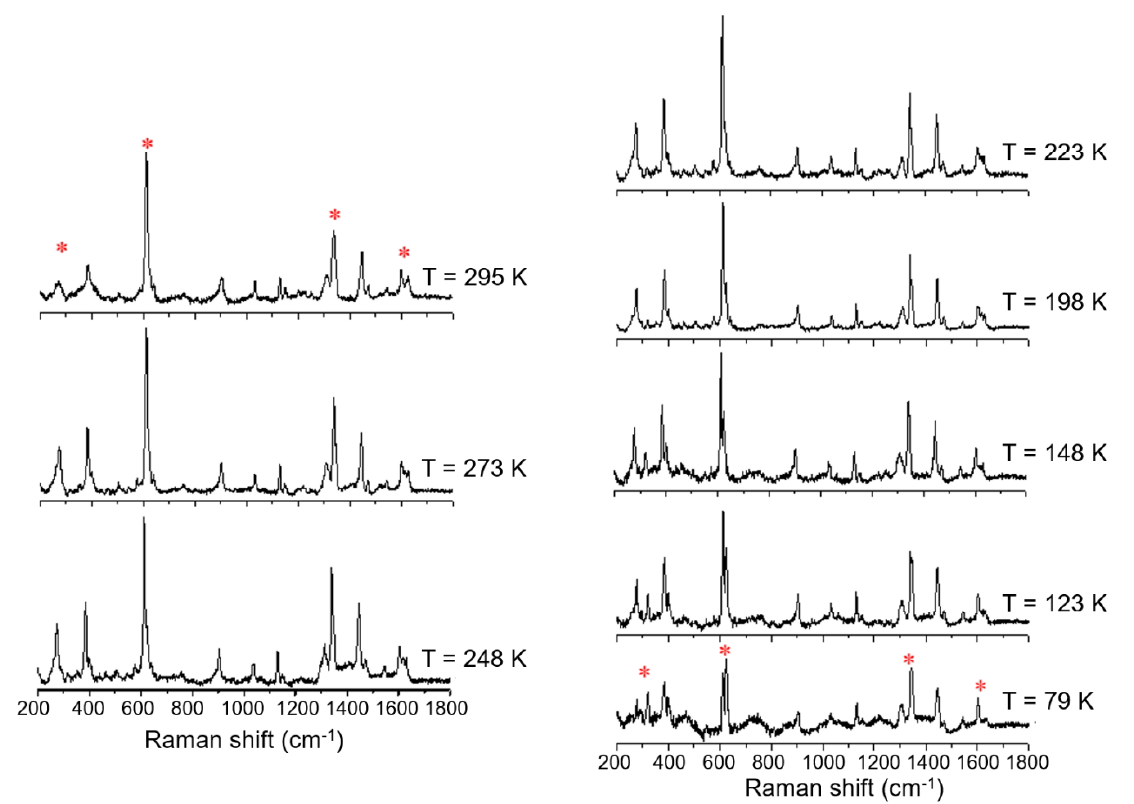
Figure 8. Variable temperature Raman spectra of [FeL 1C18 ]BF 4 , 3 , using laser excitation at 785 nm in the temperature range of 79 K to 295 K.